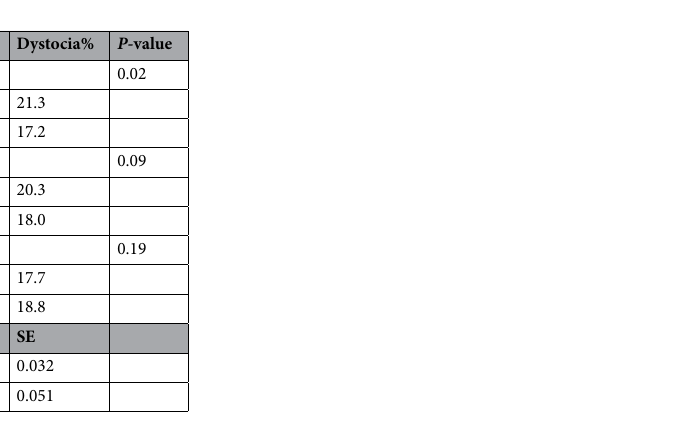
Table 4. Calving number and percentage of stillbirths for selected blood macro-minerals at parturition included in the binary logistic regression model of the generalized linear mixed model for dystocia incidence in Holstein dairy cows (n =